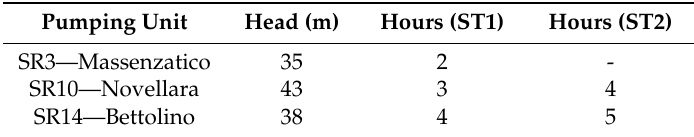
Table 5. Number of operating hours of pumping units for ST1 and ST2, with total head associated with the relative SR in the